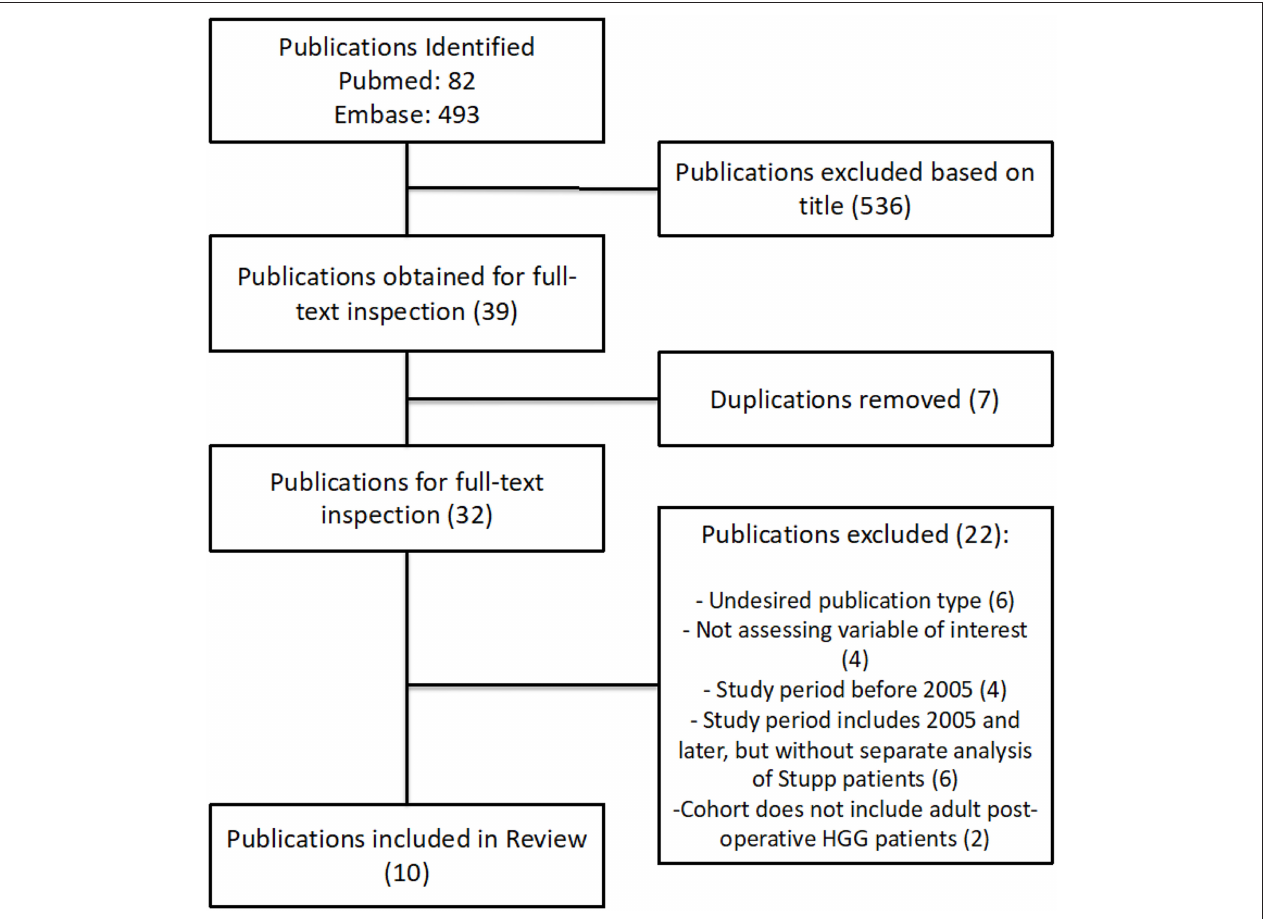
FIGURE 1 | Literature search strategy, results, and selection criteria. The search was performed on July 3, 2018. HGG, high-grade